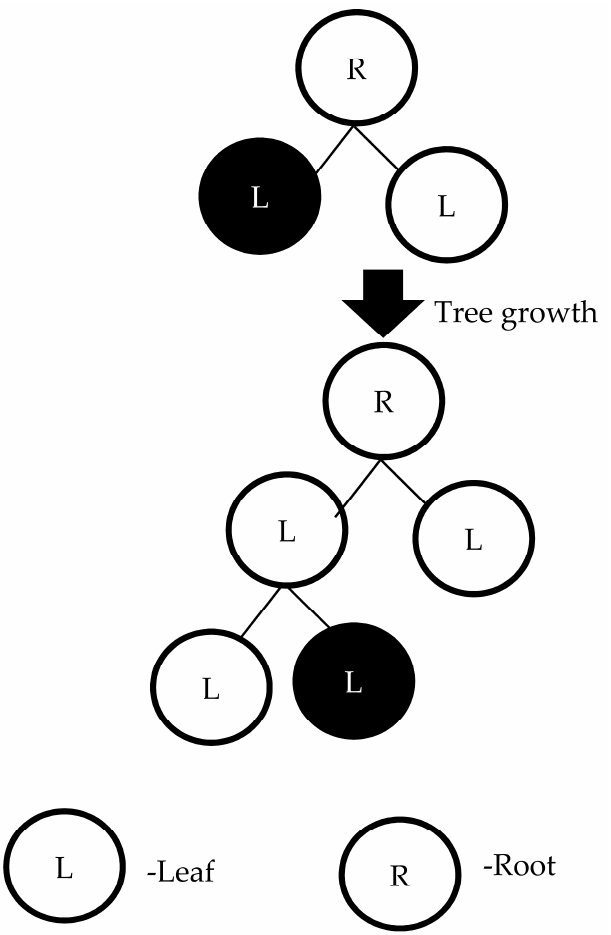
Figure 3. The tree grown leaf-wise.